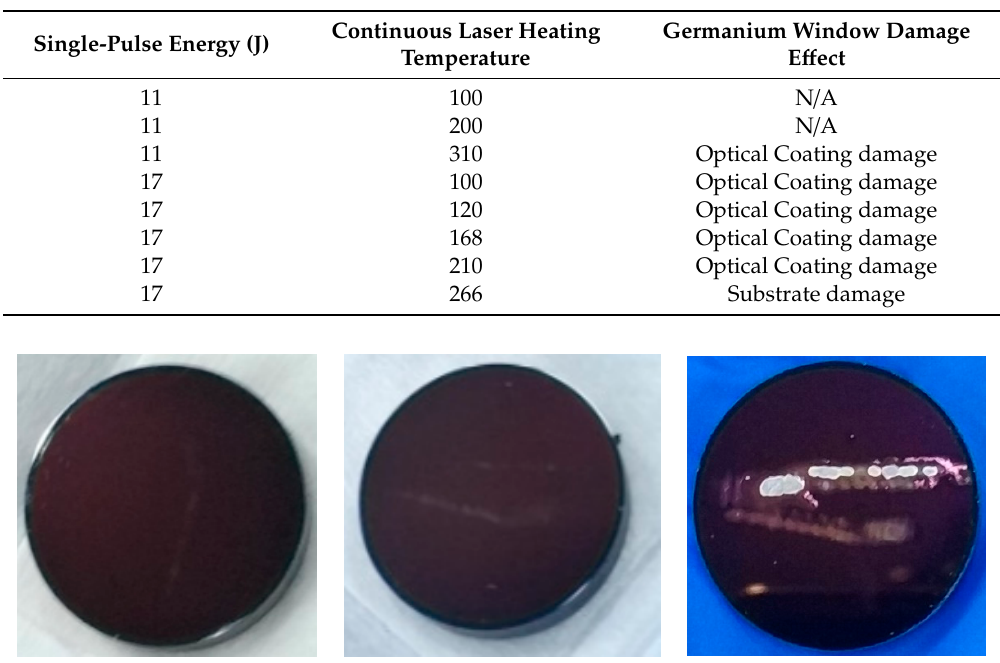
Figure 10. Damage phenomenon of the Si window by the composite laser.